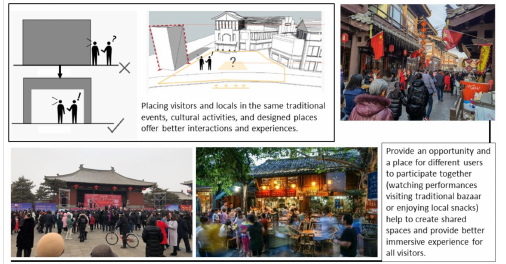
Figure 13. Creating shared spaces for all user groups contributes to the quality of the immersive experience. Source: Author.